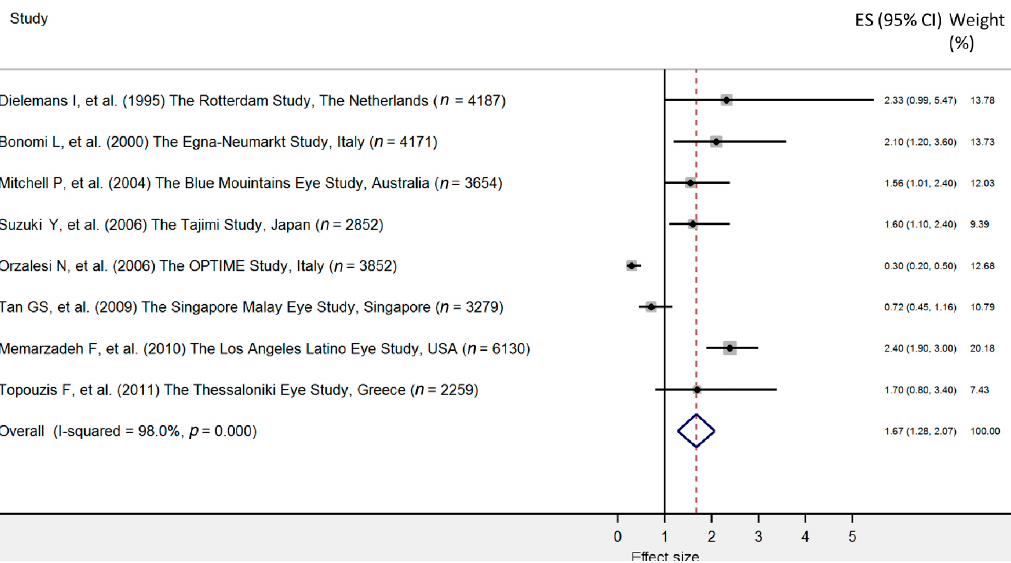
Figure 1. Forest plot of cohort studies that evaluated arterial hypertension as a risk factor for primary open angle glaucoma. The effect size (square, with size proportional to the weights used) and 95% confidence intervals (horizontal lines) is presented for each study. The overall measure revealed by pooled analysis is marked with the center of the diamond, while the associated confidence intervals are indicated by the lateral tips of the diamond [31,33,35,40,42,46,49,50].